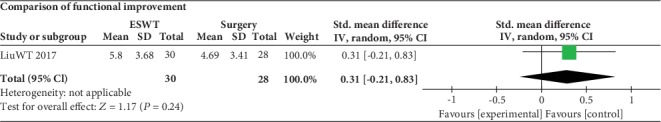
Forest plot comparing the ESWT group with the surgery group.